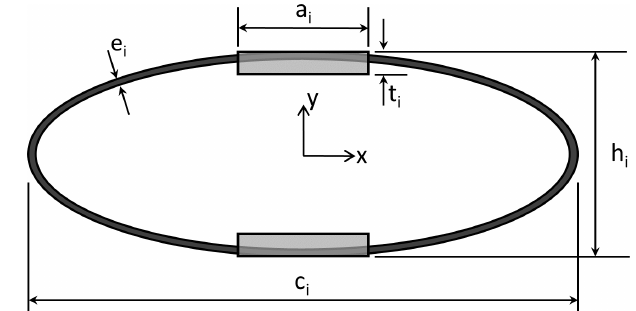
Figure 4. Simplified model of the blade structure for each cross sec- tion, as applied in STORM. The section height h and chord length c are fixed with the blade geometry for each iteration. The structural optimization design variables are then for each section the spar caps thickness t i and width a i and the ellipse thickness e i